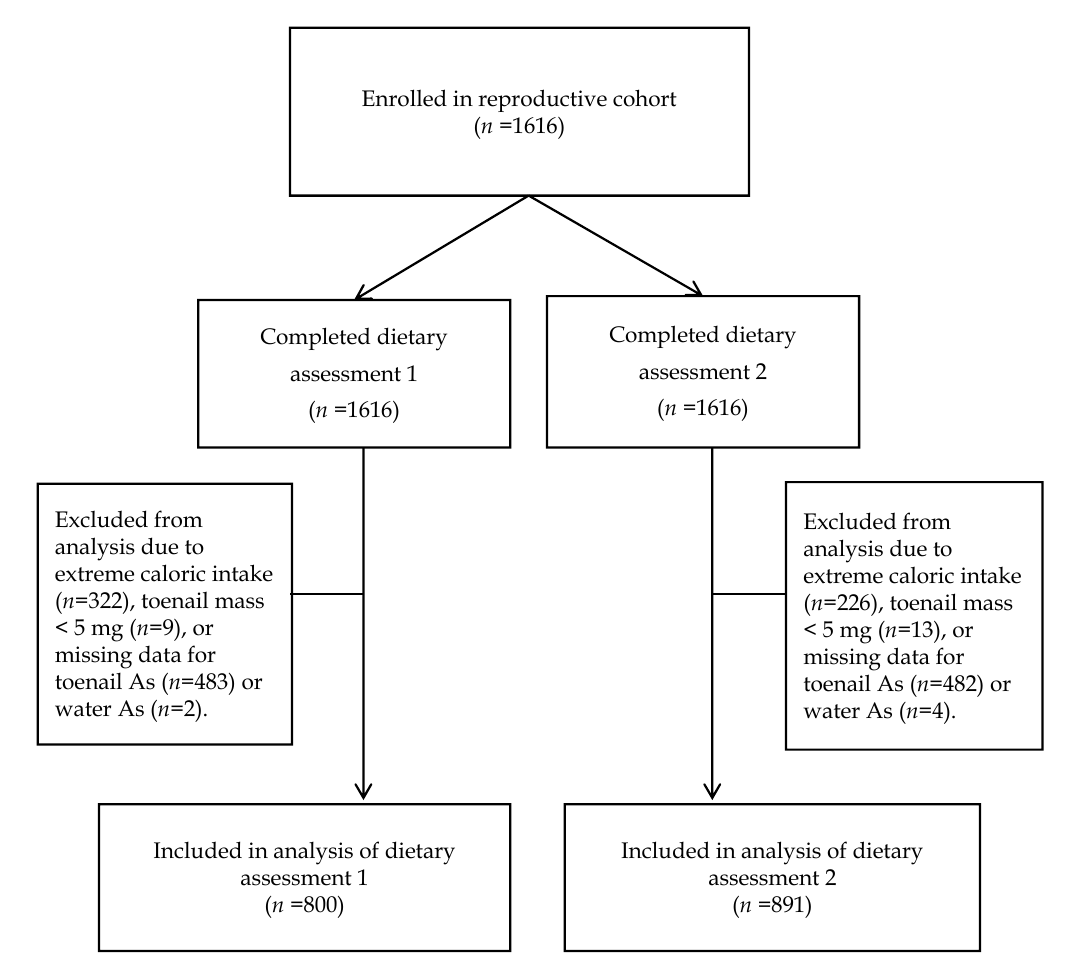
Figure 1. Study flow chart.